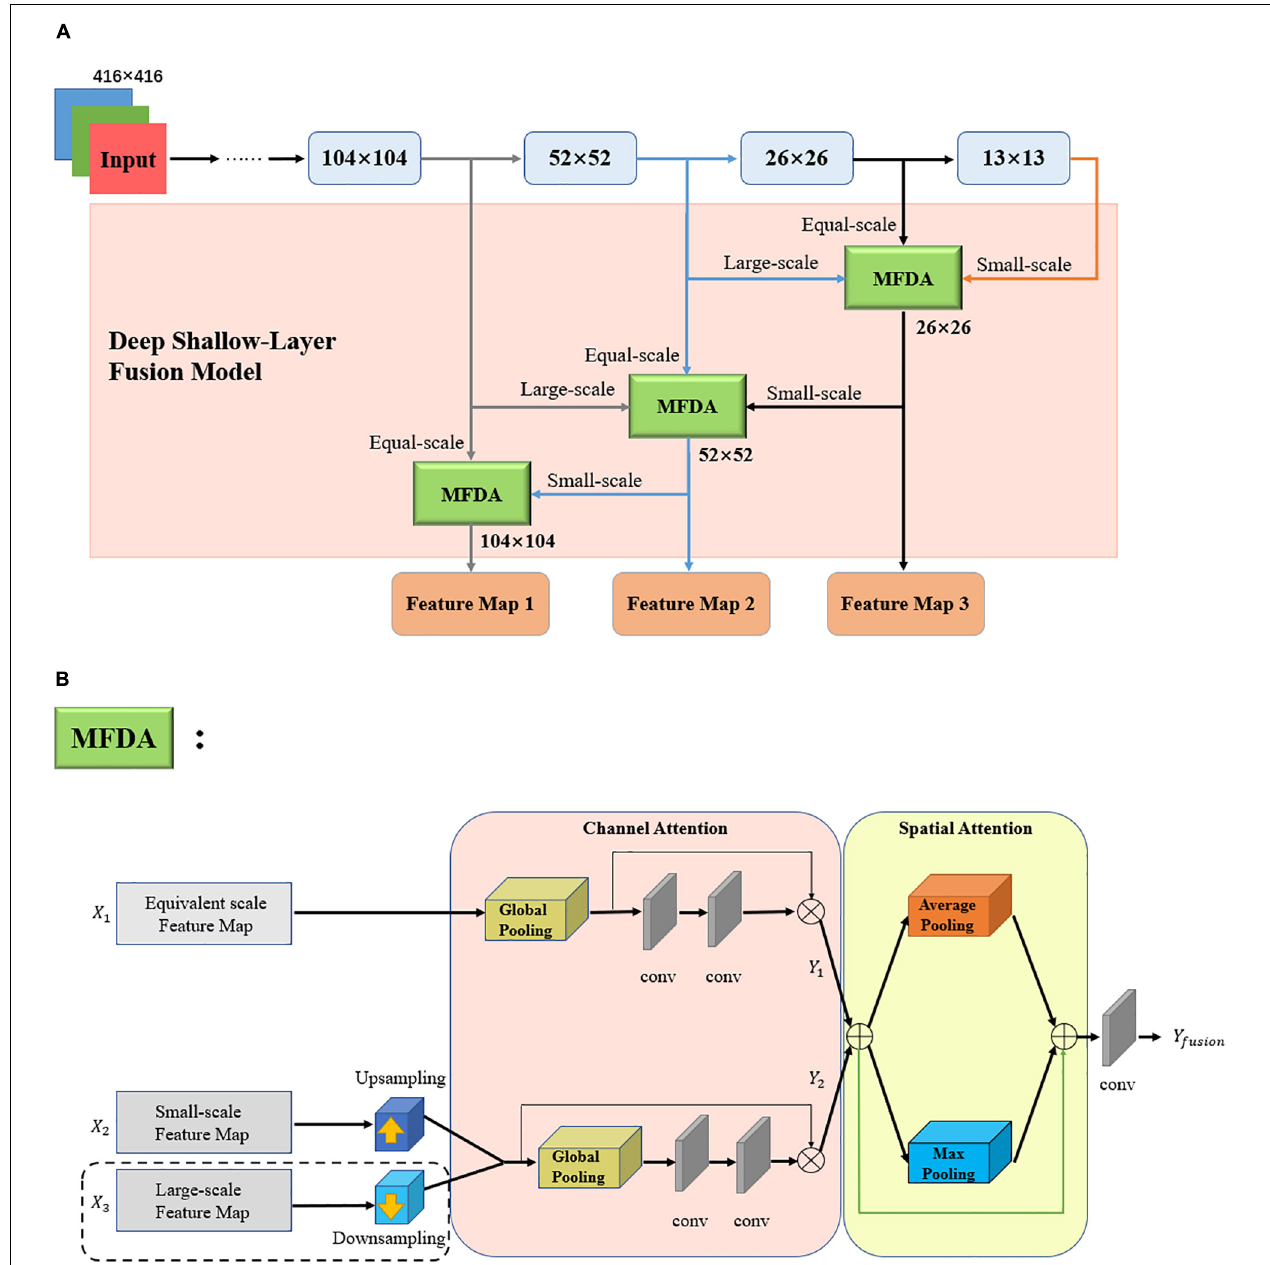
FIGURE 6 | (A) Overall architecture of the deep–shallow-layer fusion model. (B) Flow of multiscale fusion of dual attention (MFDA)